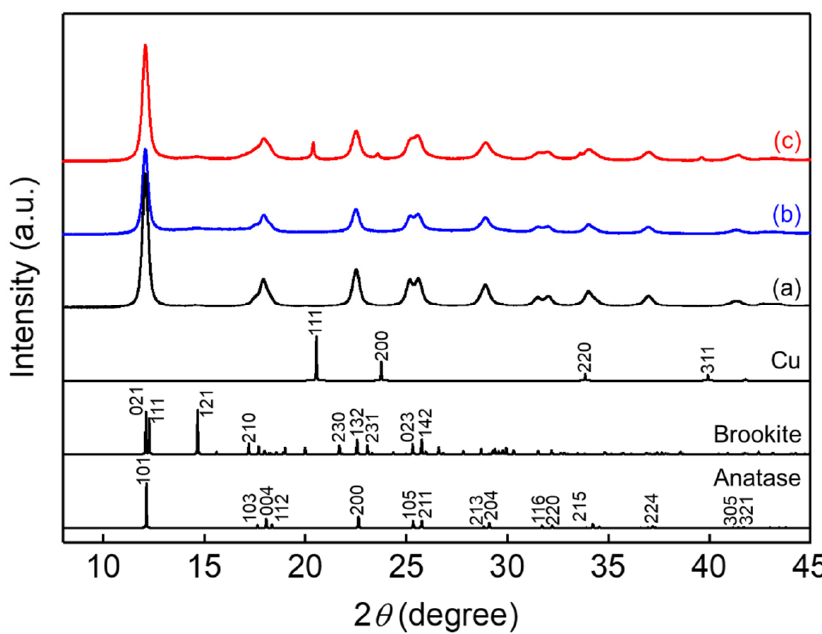
Figure 1. XRD patterns of ( a ) TiO 2 , ( b ) Cu-TiO 2 , and ( c ) Cu-TiO 2 -H. The simulated XRD patterns of anatase, brookite, and Cu are also presented.